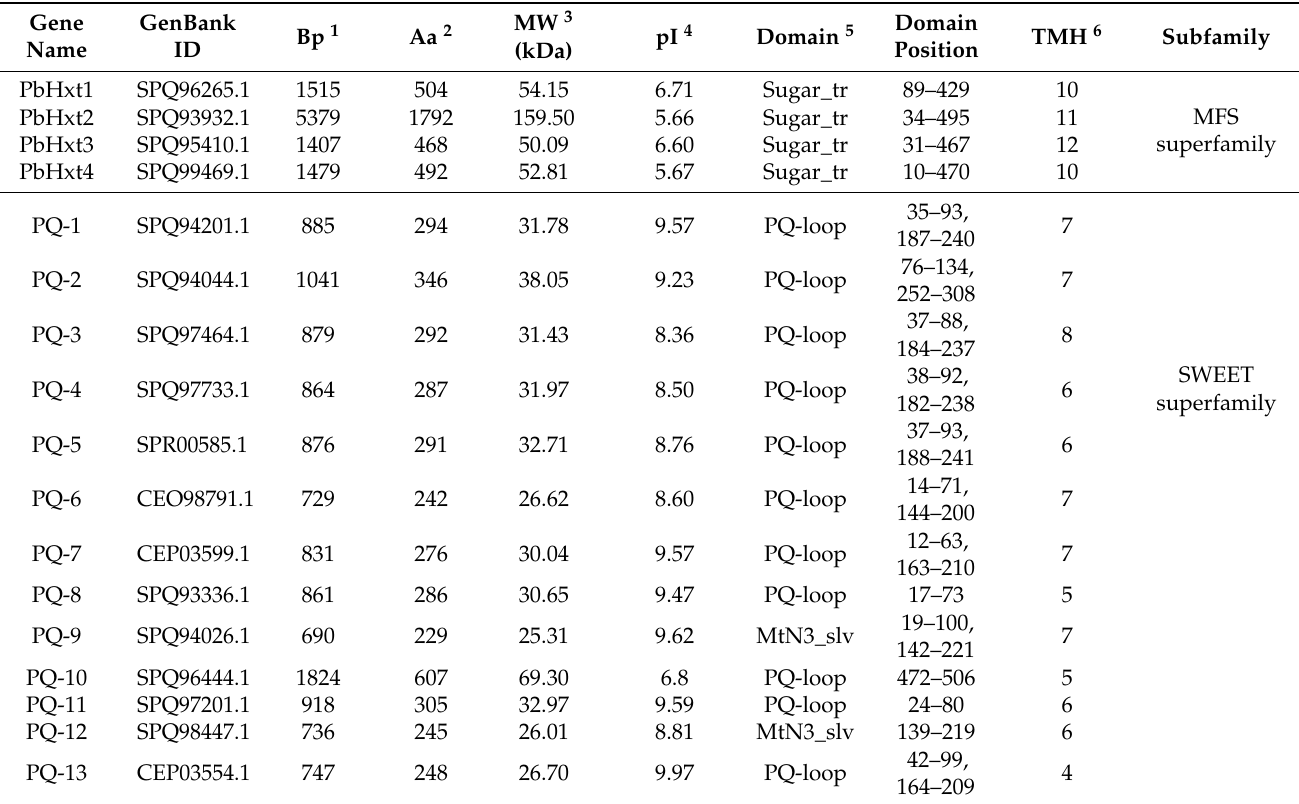
Table 1. Information on the putative sugar transporters of Plasmodiophora brassicae